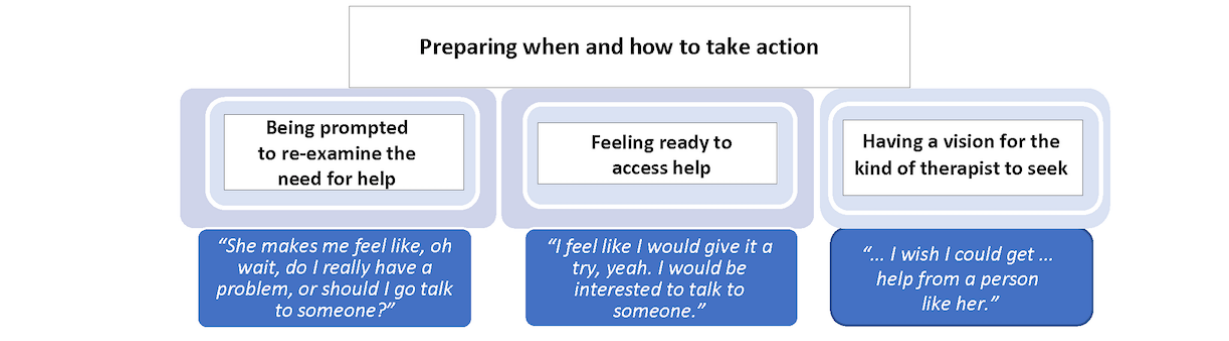
Figure 4. Properties of the category of preparing when and how to take